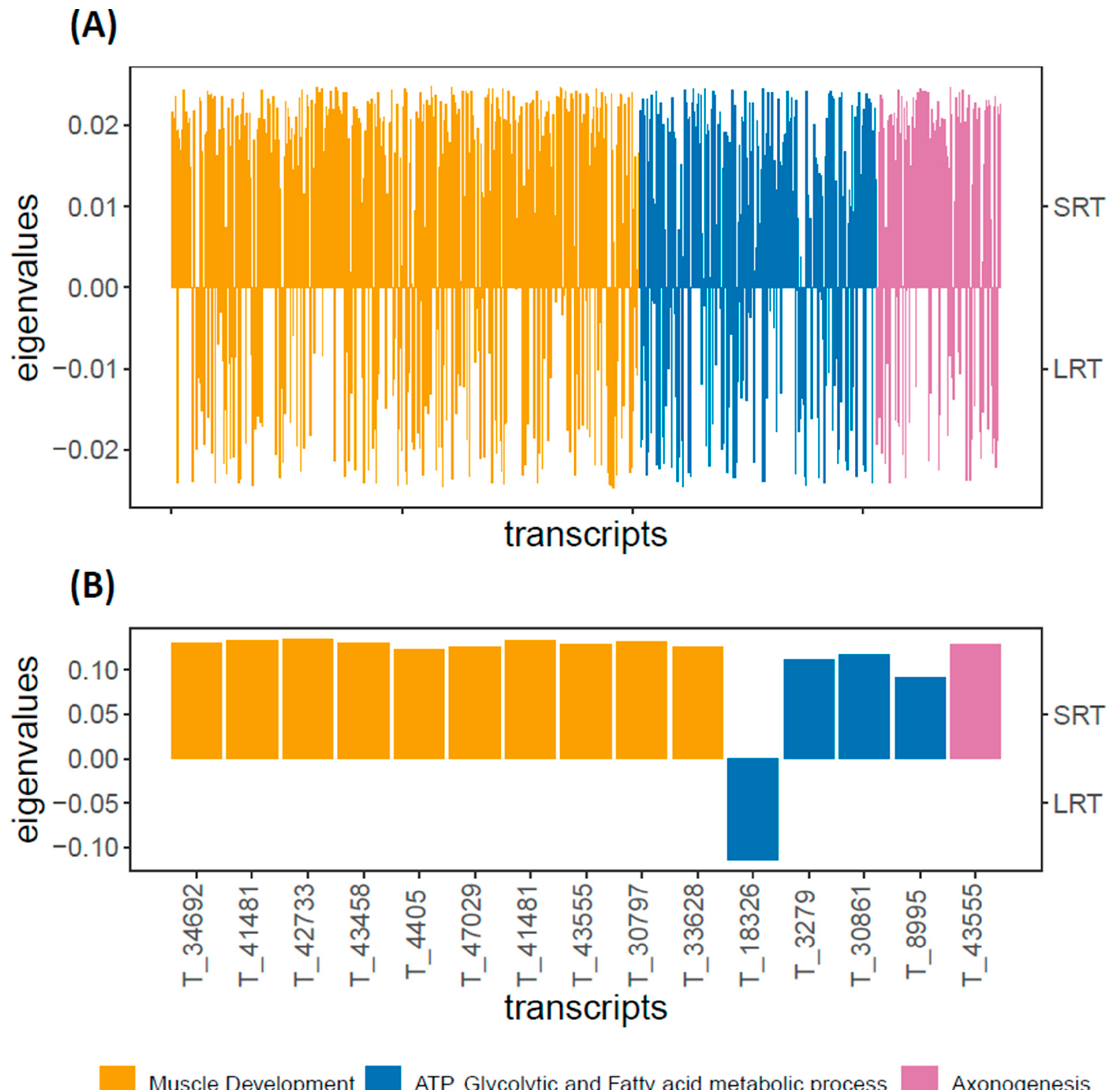
Figure 3. (A) Plot of PCA (performed with all 50,413 transcripts) eigenvalues (for PC axis 1) for all genes enriched for 36 GO terms (see Table S2), and (B) the same but only eigenvalues for the 13 DEGs (from DEG set 2) enriched (see file